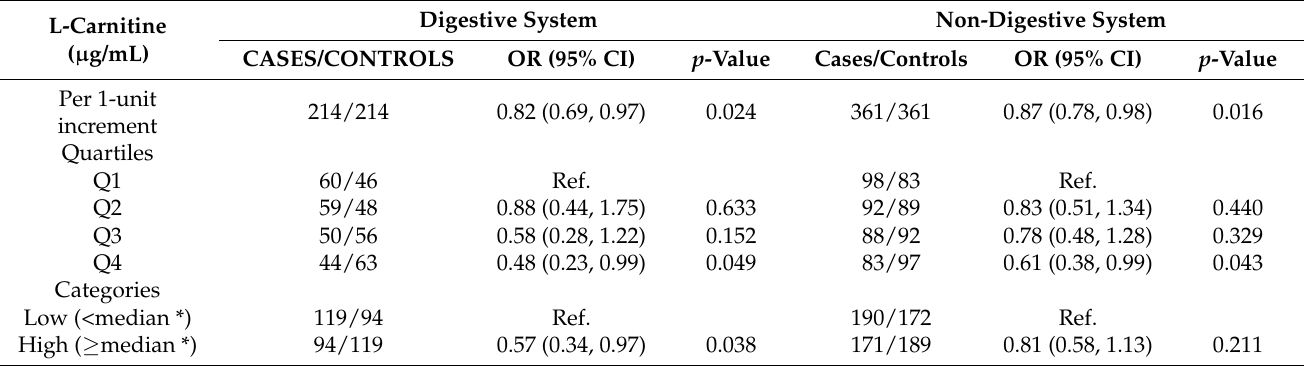
Table 3. The association of L-carnitine with digestive system and non-digestive system cancer risk.